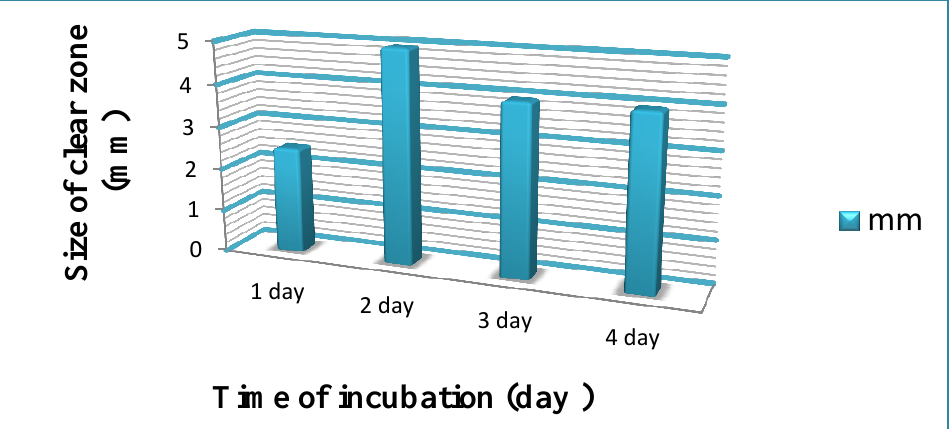
Graph (2) Size of clear zone of Bacillus subtilis when pre-cultured 1, 2 ,3 and 4 days showing